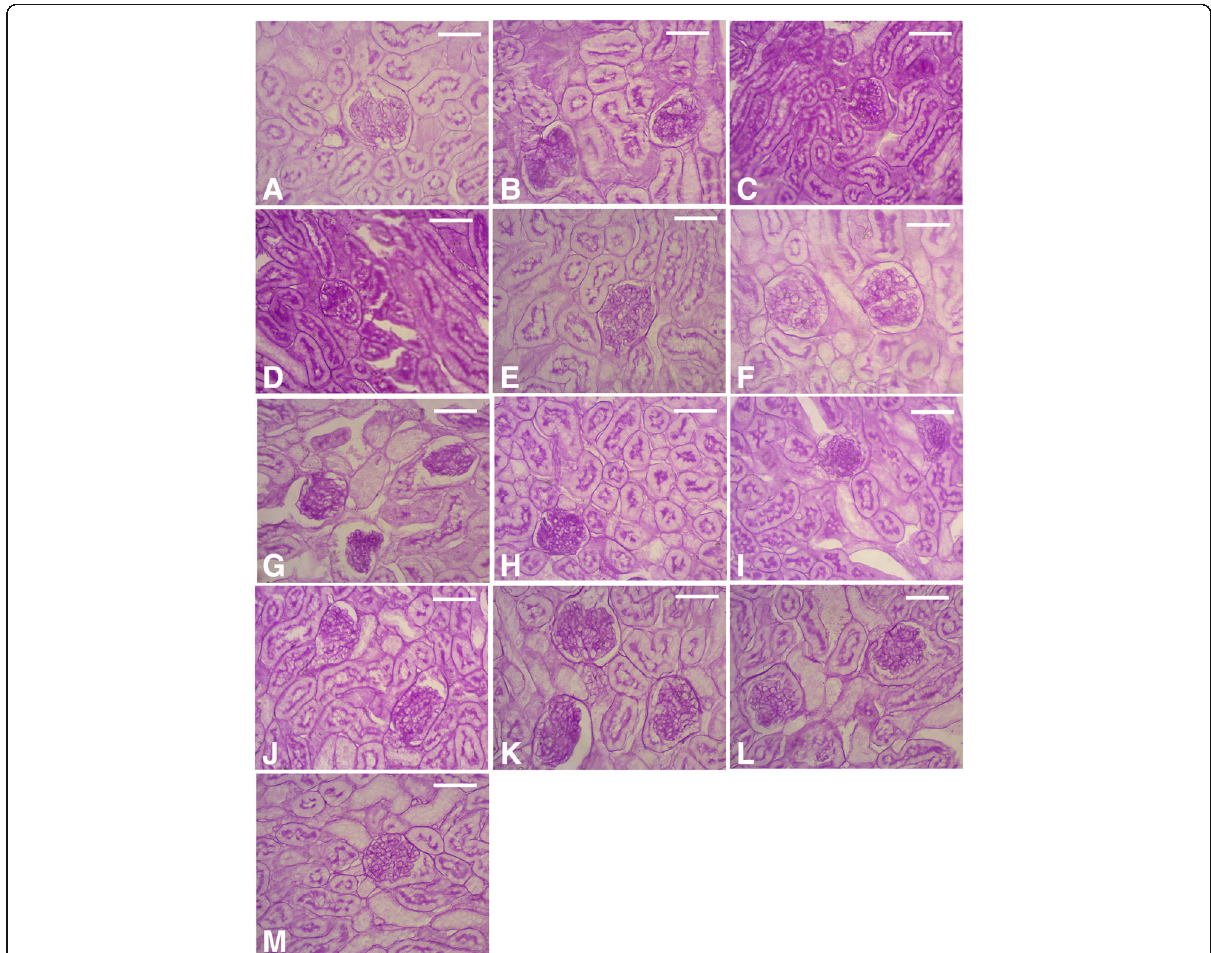
Fig. 5 Photomicrographs of PAS-stained kidney sections showing the normal PAS positivity in the glomeruli and the brush border of kidney tubules in the control group ( a ). Acrylamide-administrated groups at 30, 45, and 60 days ( b – d ) showed elevation of carbohydrates in the glomeruli and kidney tubules. Chips feeding group at 30 and 45 days ( e , f ) did not display any change as compared with the control group. At 60 days ( g ) showed the increase in the carbohydrate contents of the glomeruli and tubules as compared to the control group. BV-treated group ( h ) and BPF- treated group ( i ) at 60 days of treatment showed a similarity with the control group. Acrylamide-administrated groups treated with either bee venom ( j ) or BPF ( k ) showing improvement of carbohydrate contents. Chips feeding groups treated with either bee venom ( l ) or BPF ( m ) showing improvement of carbohydrate contents as compared to chips feeding groups. PAS staining scale bar 10 μ